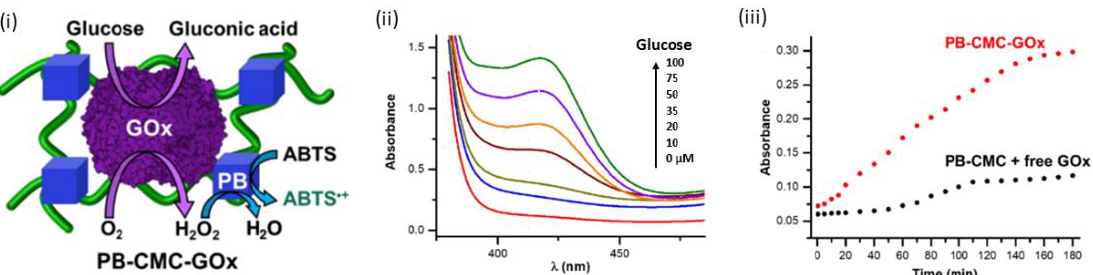
Figure 10. (i) Schematic representation of the integrated system composed of glucose oxidase (GOx) and Prussian blue nanoparticles (PB NPs) embedded within a CMC-based hydrogel (GOx-PB–CMC) and the catalyzed cascade reactions for the detection of glucose. (ii) UV-vis spectra of the ABTS • + oxidation reaction upon addition of different concentrations of glucose and (iii) comparison of the catalytic reaction rate of PB–CMC–GOx integrated system (red curve) and of PB–CMC composites with free GOx added in solution (black dots) upon addition of 20 µ M glucose, highlighting the proximity effect that cellulose operates by confining GOx and PB NPs [150]. Copyrights: all the images have been adapted and reproduced with permission from © 2022, Baretta et al., published by American Chemical Society.